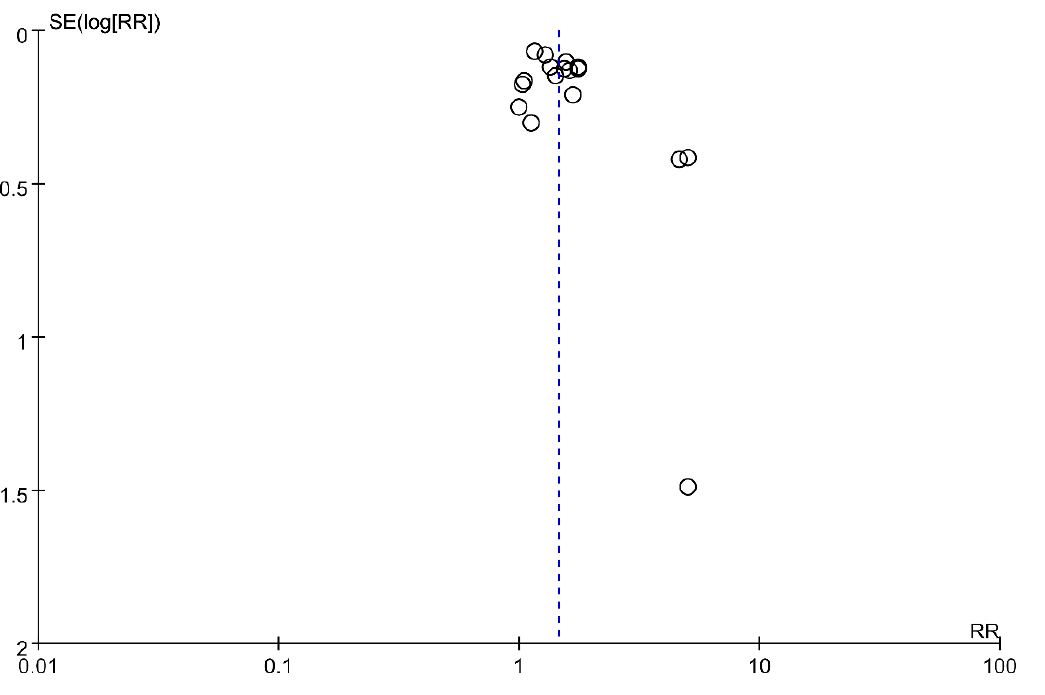
Figure 7. Funnel plot of the studies included in the meta-analysis.